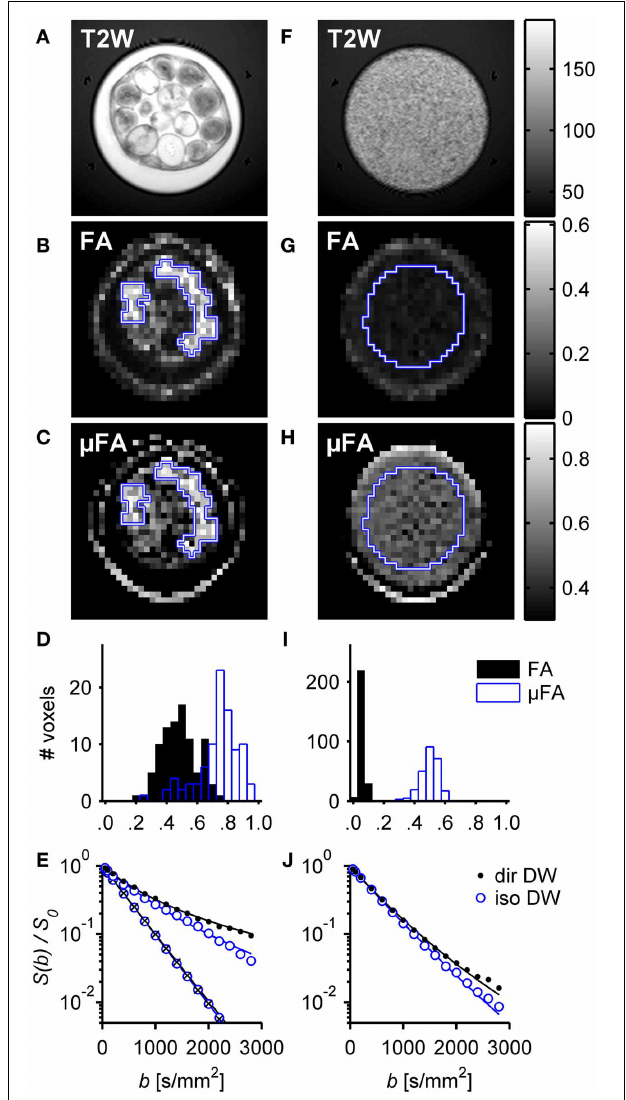
FIGURE 8 | Results of the whole-body scanner experiment on water in intact and pureed asparagus. The left column (A–E) shows the resulting images in the intact asparagus, and the right column (F–J) shows corresponding images for the pureed asparagus. The top row shows high resolution T 2 -weighted images. The second and third rows show FA and μ FA maps, respectively. A high FA is only observed in the intact asparagus while μ FA can be observed in both intact and pureed asparagus. The histograms show the distribution of FA and μ FA in the ROIs (blue outline superimposed on FA and μ FA maps). The bottom row shows normalized signal intensity vs. diffusion weighting, S ( b )/ S 0 , for representative voxels found in the ROIs (signal from isotropic DW: empty blue circles; powder-averaged directional DW: filled black circles). The bottom left plot (E) includes the signal from a region consisting of unobstructed water measured by directional (crosses) and isotropic DW (circles). The fitted regression lines, according to Equation (25), correspond to μ FA values of 0.77 and 0.47 in the intact and pureed asparagus,